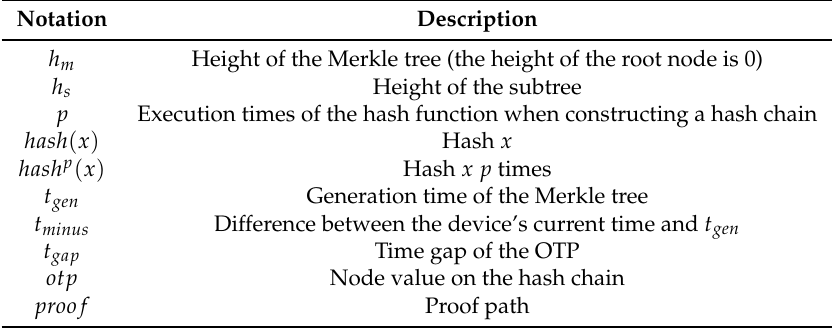
Table 1. Notation description. OTP, One-Time Password.